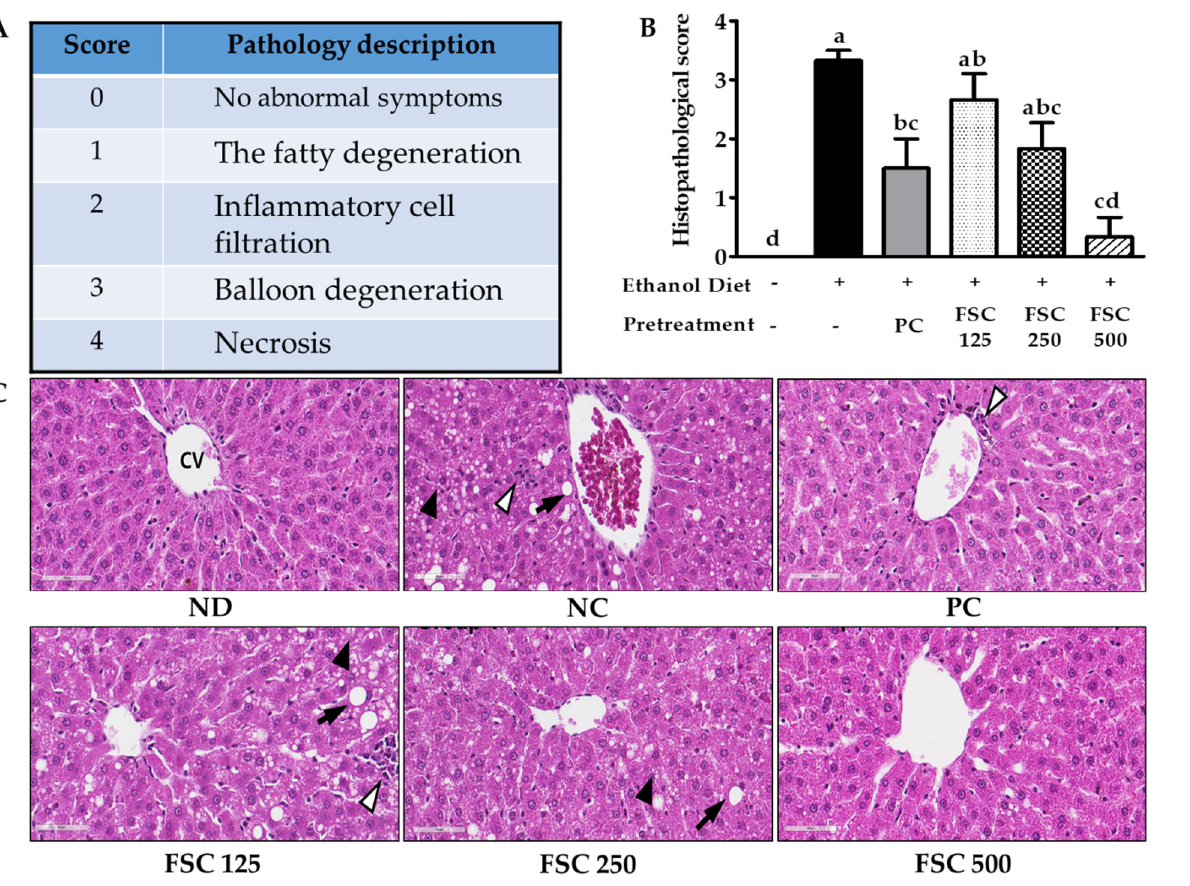
Figure 5. Liver histopathological scoring ( A ), effects of FSC on the histopathological score ( B ), and representative images of the liver histology ( C ). Group ND, normal diet; Group NC, ethanol diet only (negative control); Group PC, HDE + ethanol diet (positive control); Group FSC 125, 125 mg/kg b.w. FSC + ethanol diet; Group FSC 250, 250 mg/kg b.w. FSC + ethanol diet; Group FSC 500, 500 mg/kg b.w. FSC + ethanol diet. Data represent the mean ± SEM (n = 6). Bars with different letters show significant differences between groups ( p < 0.05) determined by analysis of variance and Tukey’s multiple comparison test. The hepatocytes were analyzed to determine necrosis, fatty change, hepatocyte ballooning, and inflammatory cell infiltration. Tissues were fixed in formalin and stained with hematoxylin and eosin (200 × ): black arrows, macrovesicular droplets; arrowheads, microvesicular droplets; white arrows, inflammatory cell infiltration; CV, central vein.